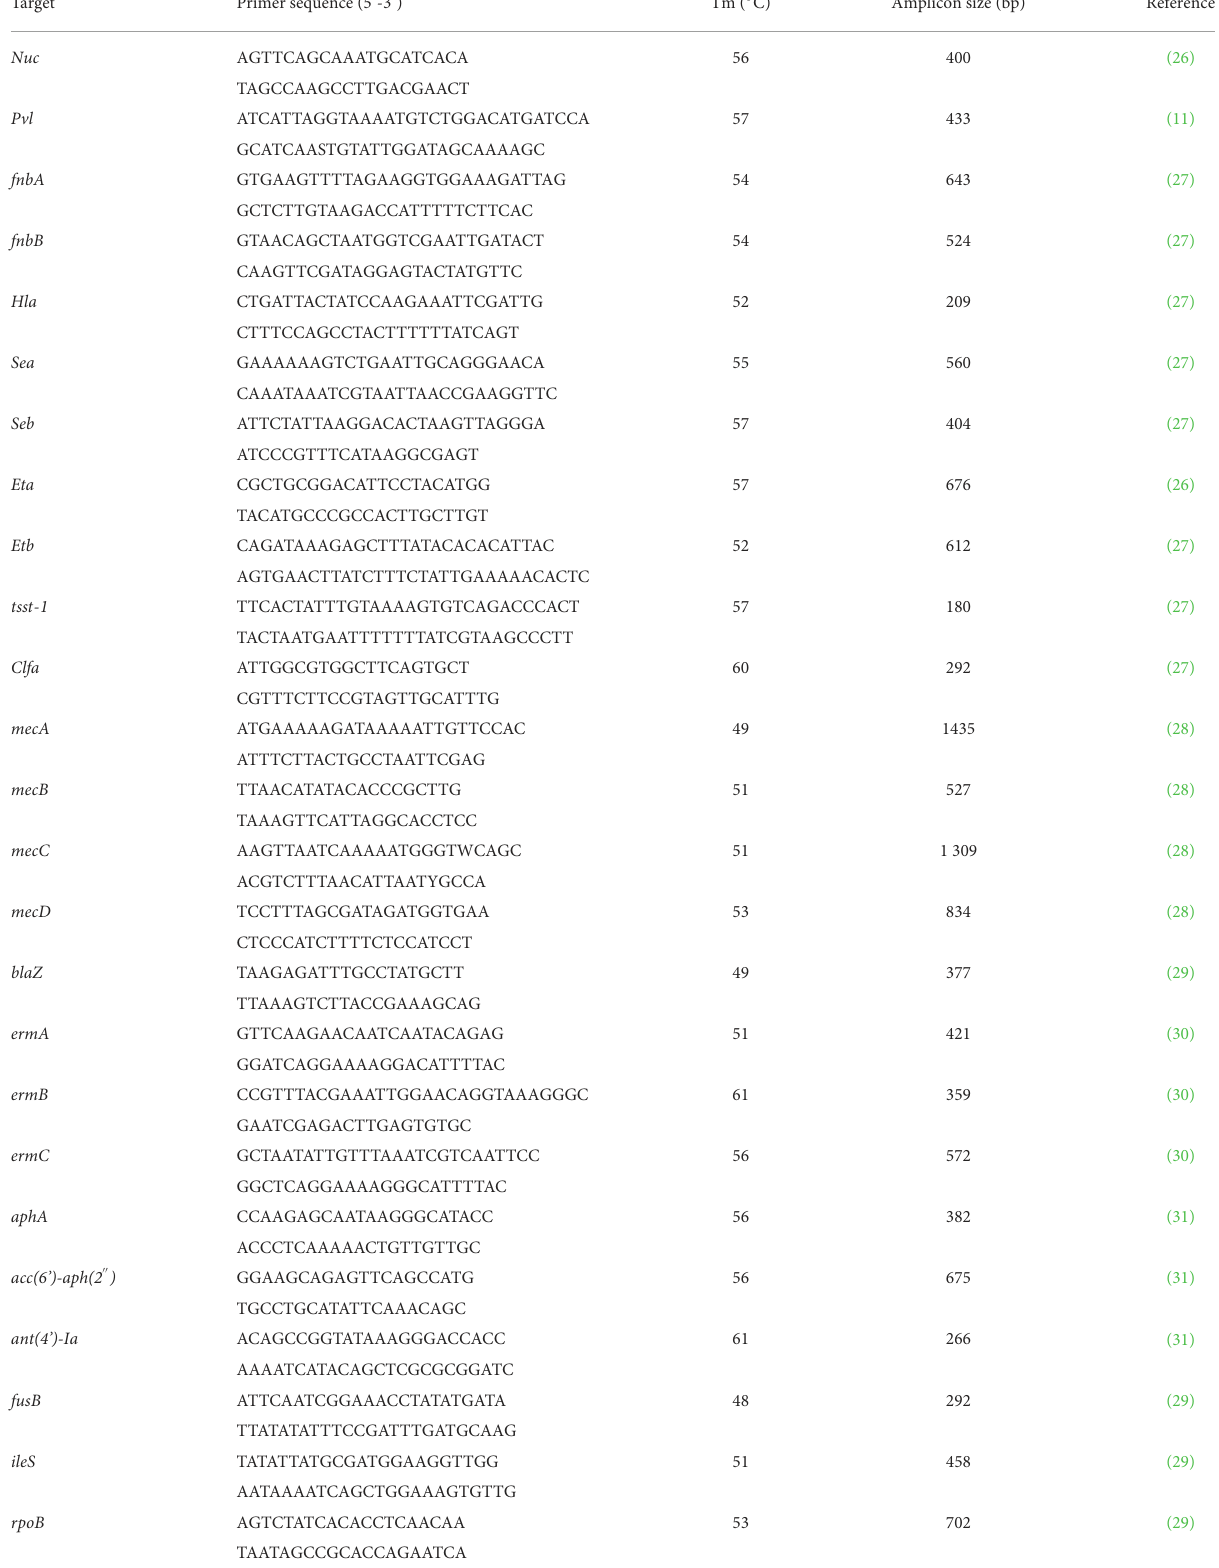
TABLE 1 The primers information of drug-resistant genes and virulence